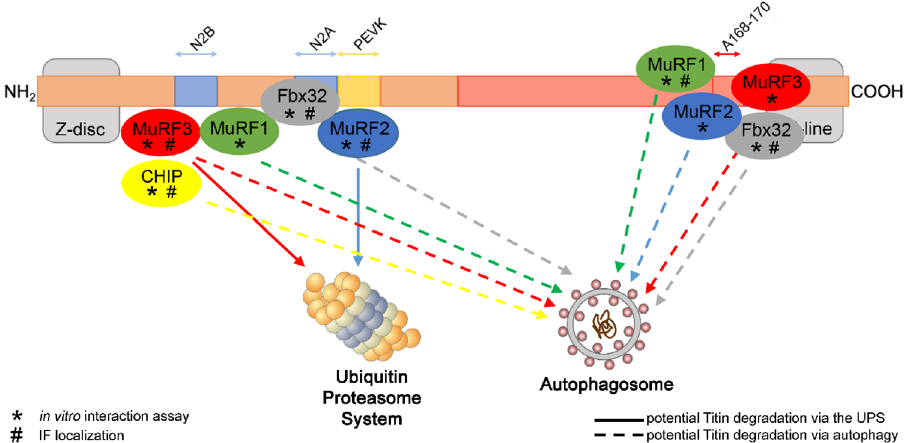
Figure 5. Schematic view of E3-ligase interaction and modification of the titin filament. The scheme illustrates a possible regulation of E3-ligase based titin ubiquitination and subsequent degradation by autophagy or the proteasome based on the in vitro pull down experiments and immunofluorescence data. Straight lines represent potential degradation via the proteasome and dashed lines degradation via autophagy after ubiquitination by the respective E3-ligase. NH2 = titin N-terminus; COOH = titin C-terminus; * = identified by in vitro interaction assay; # = identified by immunofluorescence